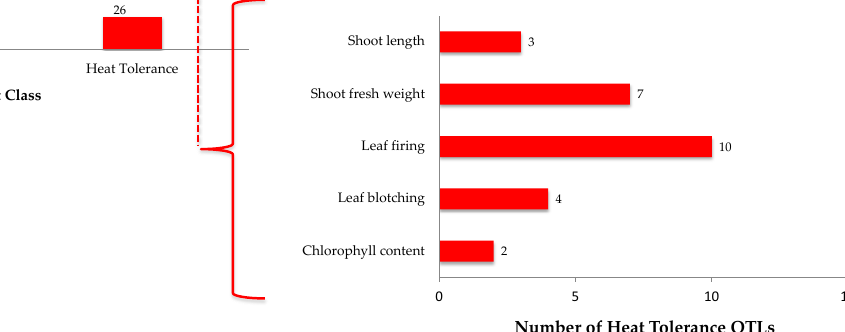
Figure 4. Quantitative traits and Quantitative Trait Loci (QTLs) identified for drought or heat stress in sorghum. Briefly, there were several QTLs reported for abiotic stress tolerance in sorghum. These were grouped into two categories, i.e., drought tolerance and heat tolerance. There were twelve traits associated with drought tolerance with 245 QTLs, while there were 26 QTLs for five traits associated with heat tolerance (HT) in sorghum. Validation of these QTLs and genes under these loci will add value for precise selection and direct transfer major effect QTLs for target traits (drought or HT) in sorghum crop improvement. Represented stay- green, green leaf area and chlorophyl content for drought are widely studied and may help in decoding the probable mechanisms governing drought tolerance genetic control, whereas QTLs for HT are limited and yet to be exploited for potential